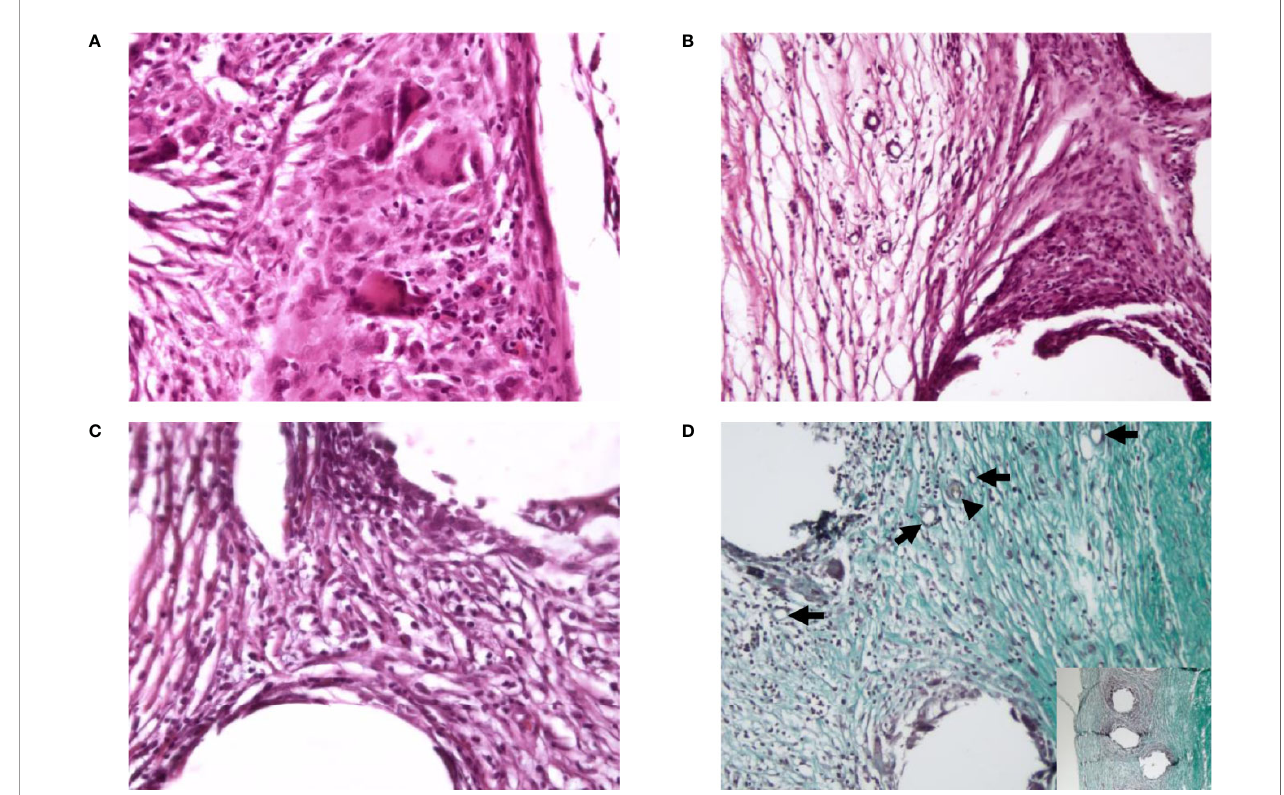
FIGURE 6 | Representative fi gures of the histology of a control case and a cell case 1 month after implantation. (A) Polymorphonuclear cells around the mesh, along with in fl ammatory giant cells in a control case. Hematoxylin – eosin, ×40 objective. (B) Highly cellular connective tissue between the mesh with few collagen fi bers below the mesh area in a control case. Hematoxylin – eosin, ×20 objective. (C) Presence of mononuclear in fi ltrate with few polymorphonuclear cells around the mesh in a cell case. Hematoxylin – eosin, ×40 objective. (D) Moderately dense connective tissue-enriched blood vessels ( arrows ; including arteriole, arrowhead ) with some organization of the collagen fi bers is present between the mesh fi bers in a cell case. Note the dense organized connective tissue with parallel bundles of fi bers below the mesh ( inset ). Masson Trichrome, ×20 objective and ×10 objective ( inset